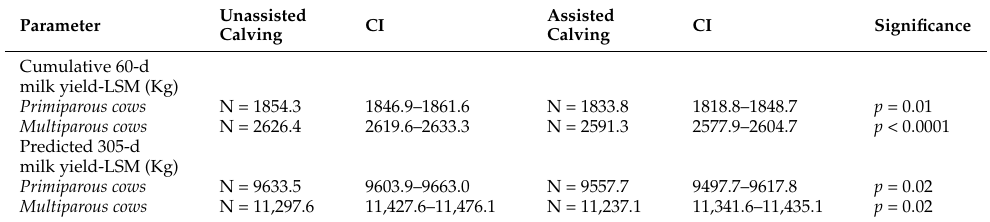
Table 5. Least square means and 95% confidence intervals for milk production according to calving